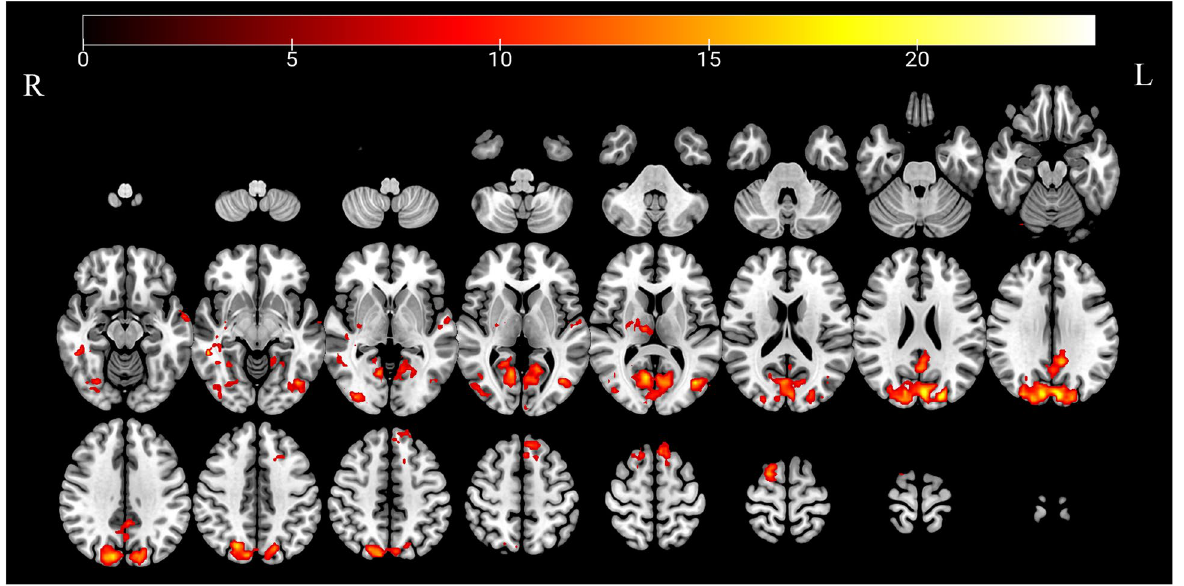
Fig. 2 Significant differences in sALFF among different times after triggering the pain in patients with CTN. sALFF, Static amplitude of low-frequency fluctuation; CTN, classical trigeminal